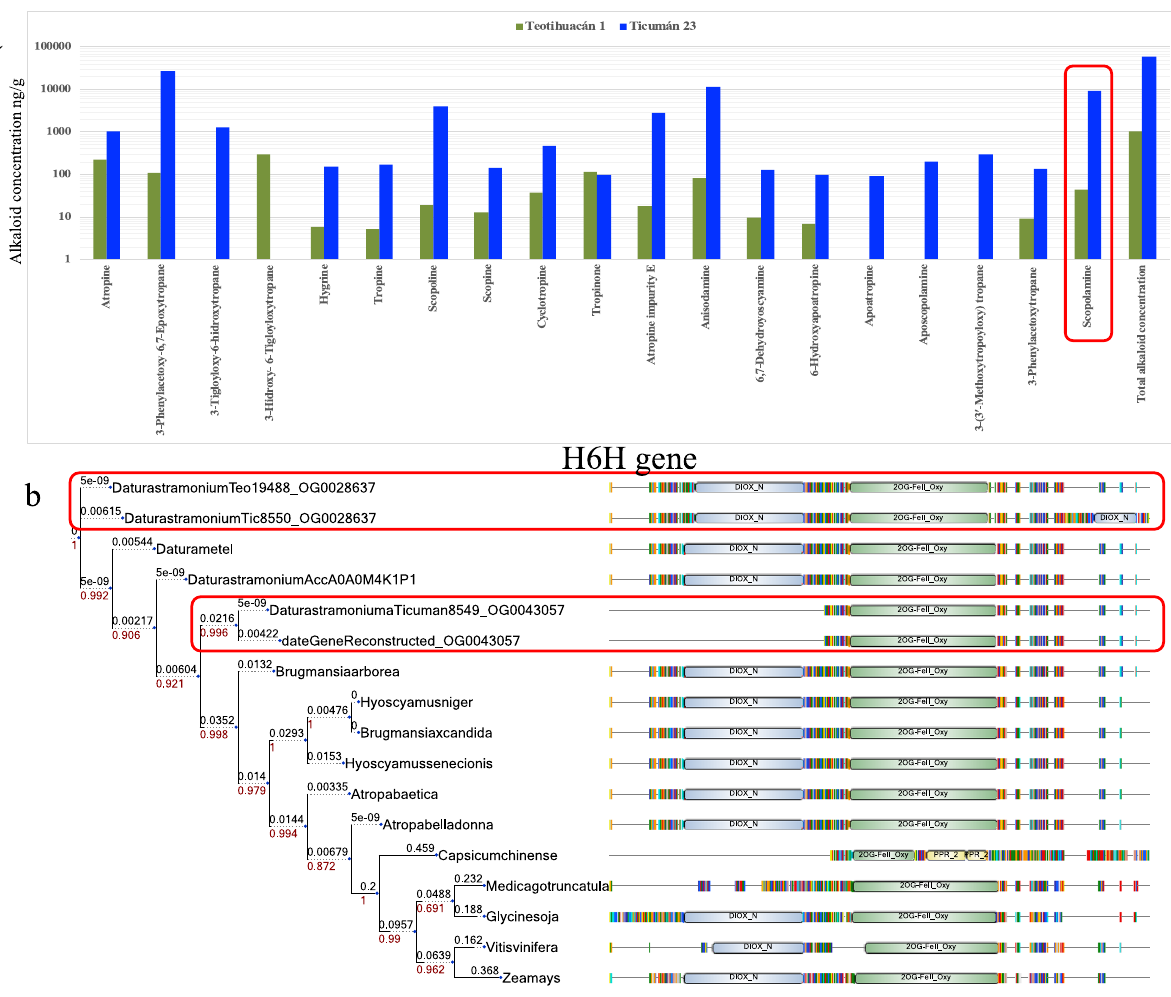
Figure 5. ( a ) Tropane alkaloid differentiation between Ticumán and Teotihuacán plants (Log scale) that were used to sequence their genomes. Almost all tropane alkaloids showed higher concentration in Ticumán than the Teotihuacán plant. Scopolamine alkaloid is highlighted with a red box. ( b ) h6h gene phylogeny was generated using 17 genes. Results revealed that two copies of h6h are found in both genomes of D. stramonium (highlighted with a red box). These two gene copies were distributed in two different gene families (OG0028637 and OG0043057). The name of the family was added at the end of the gene name. The gene DaturastramoniumTic8550_OG0028637 (Ticumán genome) have two domains of DIOX_N (PF14226), while all its homologous of the phylogeny only have one DIOX_N domain. The higher production of scopolamine alkaloid in the Ticumán genome could be related with this additional domain and different architecture in the Ticumán h6h